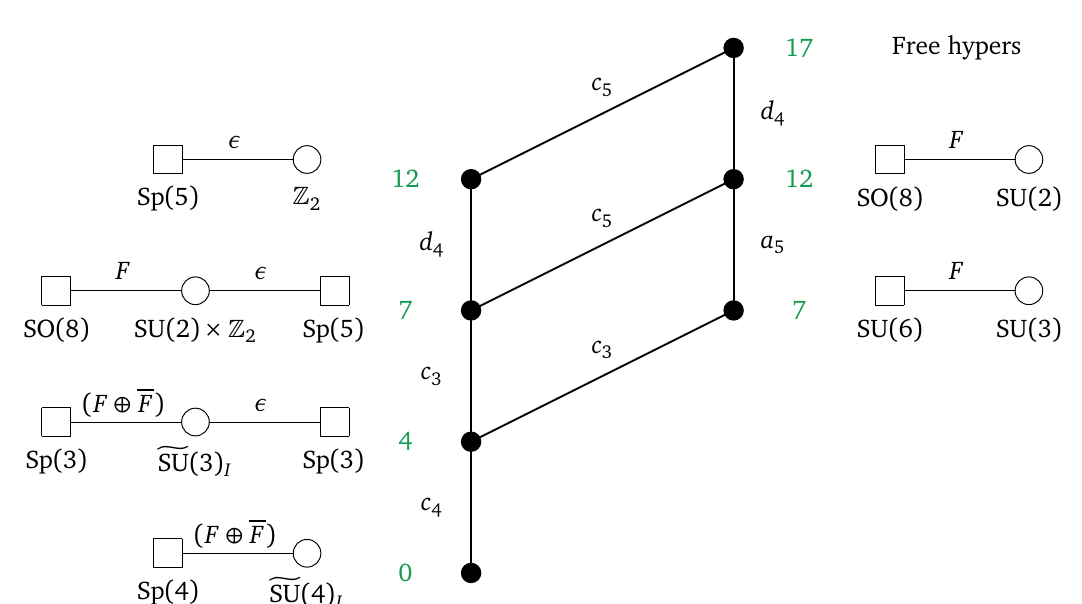
+ 4 ( F ⊕ F ) . Next to each symplectic I